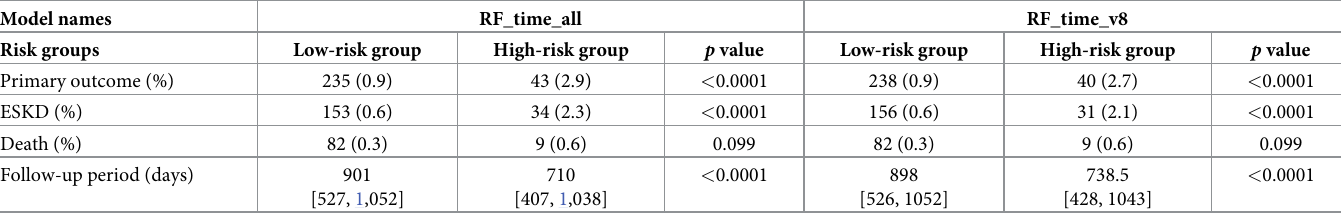
Table 2. Outcome events of risk groups classified on the basis of machine-learning